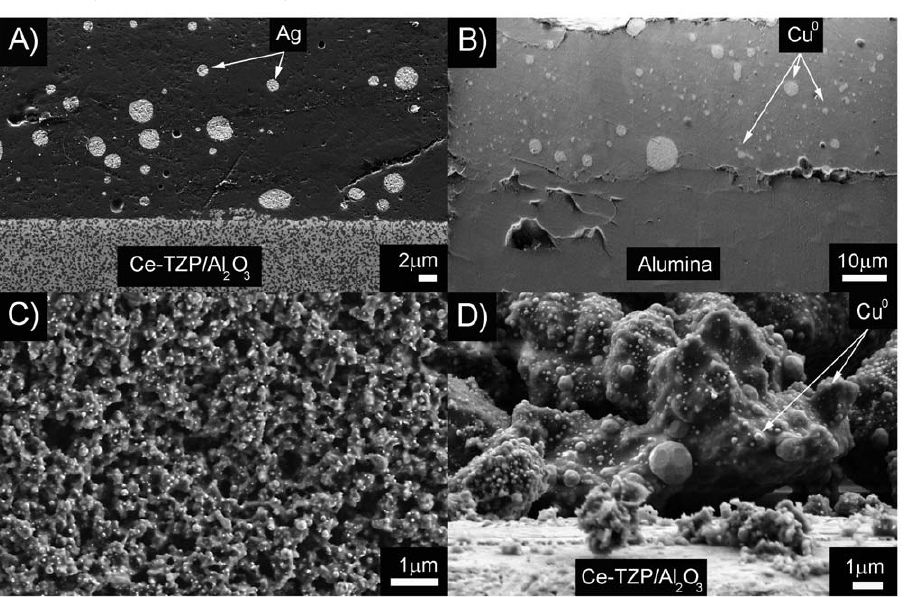
Figure 3. Scanning electron micrographs corresponding to: A) cross-section of n-Ag glass coating on Ce-TZP/nAl 2 O 3 substrate sintered at 740 6 C, 1 h in air atmosphere; B) cross-section of n-Cu glass coating on alumina substrate sintered at 1150 6 C, 1 h in argon atmosphere; C) top view and D) cross-section of n-Cu glass coating on Ce-TZP/nAl 2 O 3 substrate sintered at 850 6 C, 1 h in argon atmosphere.